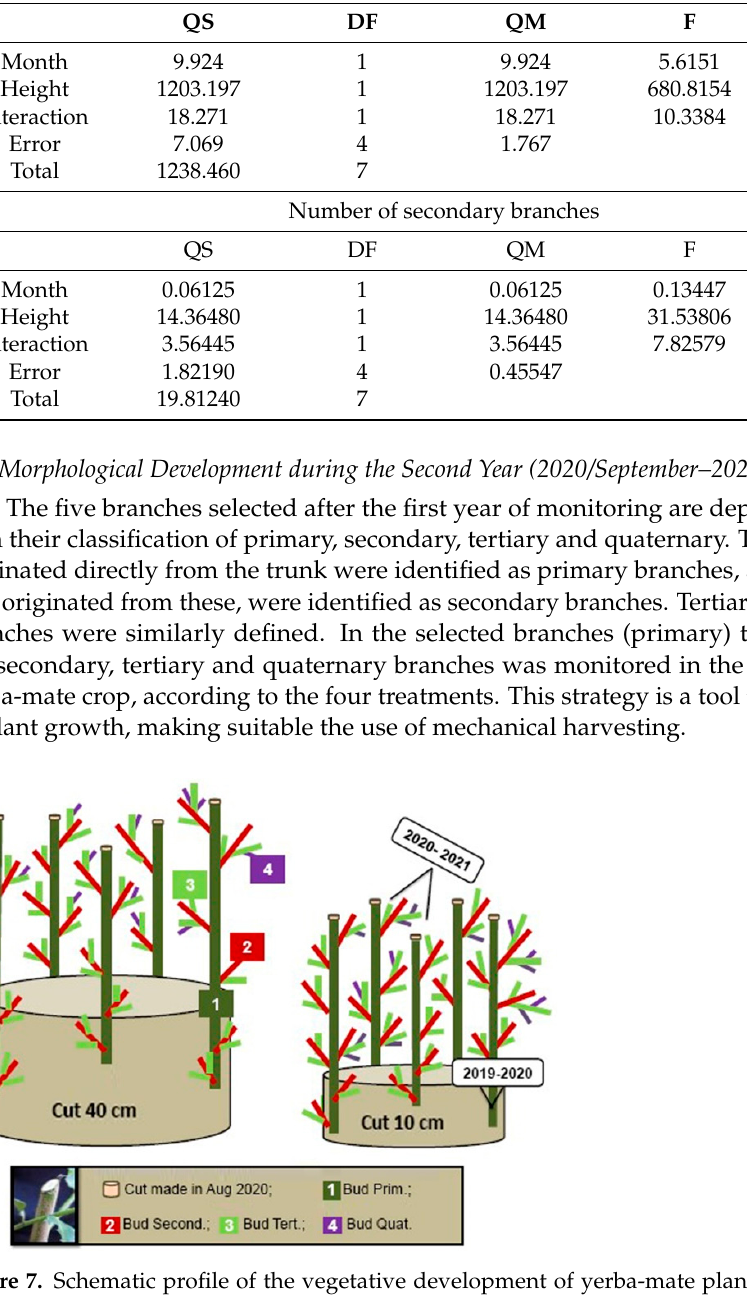
Figure 7. Schematic profile of the vegetative development of yerba-mate plants after removal of unnecessary branches.